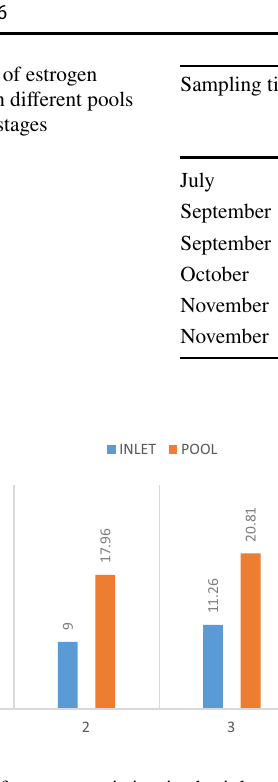
Fig. 1 Results of estrogen existing in the inlet water and the average water for each pool Fig. 2 Concentration changes of estrogen during July to December